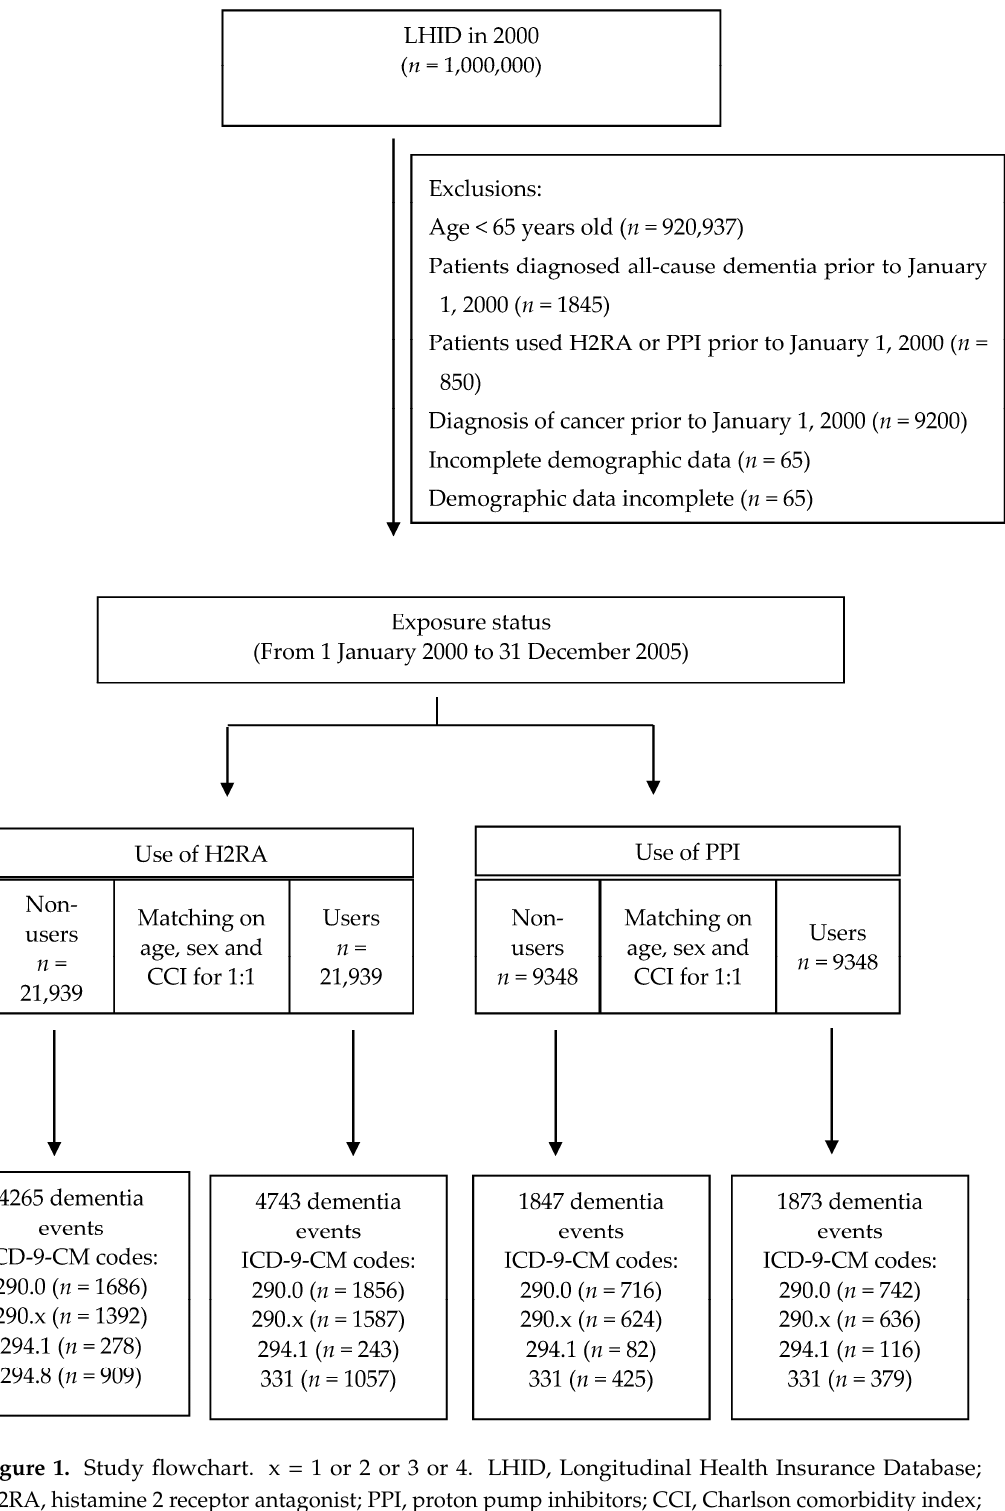
Figure 1. Study flowchart. x = 1 or 2 or 3 or 4. LHID, Longitudinal Health Insurance Database; H2RA, histamine 2 receptor antagonist; PPI, proton pump inhibitors; CCI, Charlson comorbidity index; ICD-9-CM, International Classification of Diseases, 9th Revision, Clinical Modification.